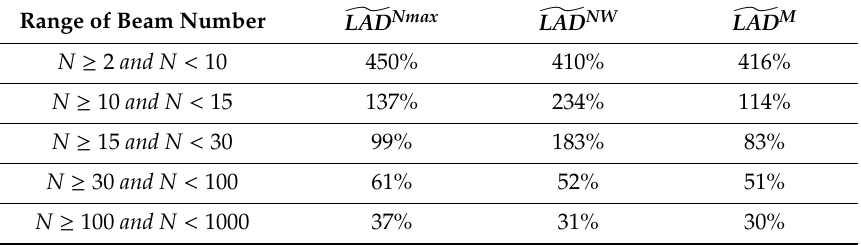
Table 3. Root Mean Square Error (in % of the mean LAD ) of the three multiview estimators for six di ff erent classes of total beam